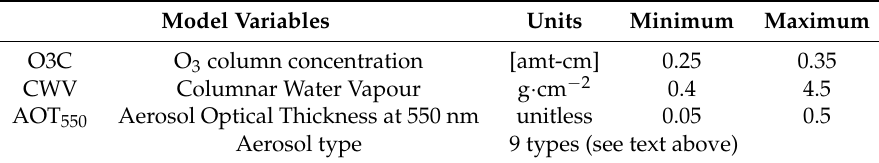
Table 4. Range of MODTRAN input variables for the reference_toa subset according to Latin Hypercube sampling. MODTRAN fixed geometric variables: solar zenith angle: 30 ◦ ; viewing zenith angle: 0 ◦ . Remaining MODTRAN parameters were set to their default